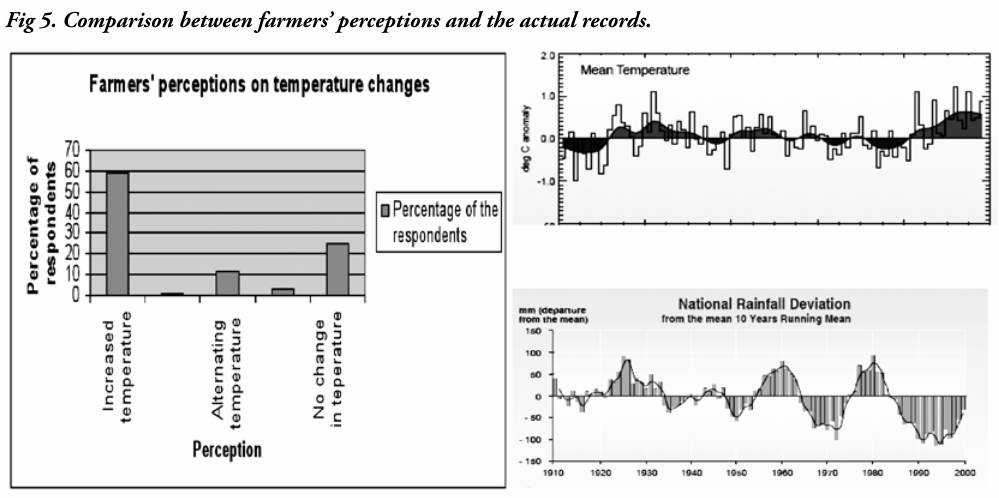
Fig 5. Comparison between farmers’ perceptions and the actual